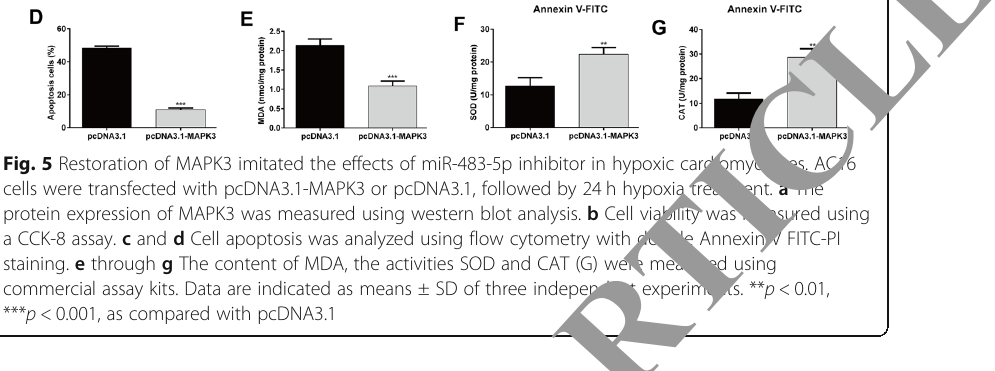
miR-483-5p inhibitor downregulated the expression of MAPK3 compared with cells transfected with the miR-483-5p inhibitor alone (Fig. 6a). The CCK-8 assay (Fig. 6b) and flow cytometry assay (Fig. 6c and d) showed that MAPK3 knockdown markedly re-